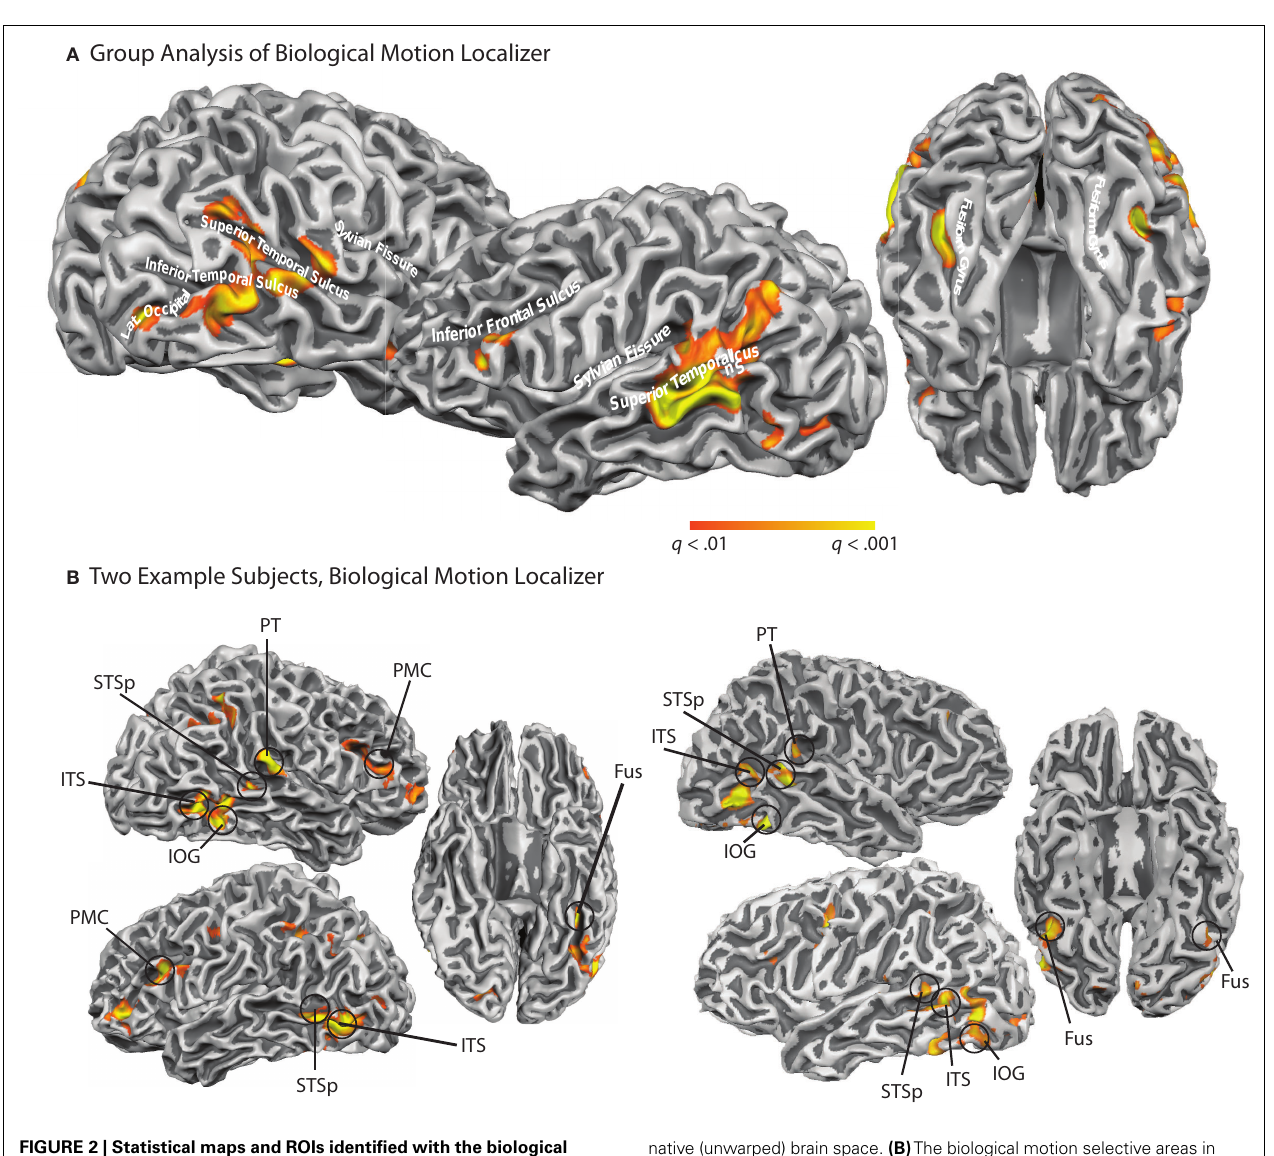
native (unwarped) brain space. (B) The biological motion selective areas in two individual subjects, shown in native brain space. These two representative subjects demonstrate the range of variability we observed across the subject population for this localizer. All statistical maps (biological motion – scrambled motion) are corrected with a false discovery rate of q < 0.01. STSp, posterior superior temporal sulcus; ITS, inferior temporal sulcus; IOG, inferior occipital gyrus; Fus, posterior fusiform; PMC, premotor cortex; PT, posterior planum